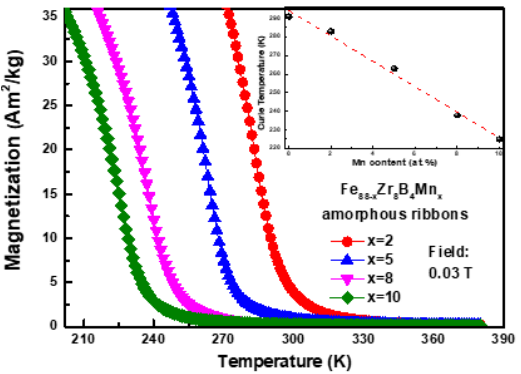
Figure 4. The temperature dependence of the magnetization (M-T) curves of the Fe 88 − x Zr 8 B 4 Mn x samples, inset the compositional dependence of T c in Fe 88-x Zr 8 B 4 TM x (TM=Co, Mn) metallic glasses. Figure 5 shows the hysteresis loops of the amorphous Fe 88 − x Zr 8 B 4 Mn x (x = 0, 2, 5, 8 and 10) samples measured at 200 K under 5 Tesla. The ribbons are all soft magnetic and exhibit negligible coercivity, indicating that the new series of FeZrB alloys is similar to the based alloys that are potential materials for practical application because they can easily be magnetized and demagnetized. The saturation magnetization ( M s ) of the Fe 88 − x Zr 8 B 4 Mn x glassy ribbons is about 109 Am 2 /kg for x = 0, 94.6 Am 2 /kg for x = 2, 80.3 Am 2 /kg for x = 5, 65.4 Am 2 /kg for x = 8 and 58.33 Am 2 /kg for x = 10. To facilitate observation, Figure 5 plots the variation curve of M s and Mn content inset in the lower right corner. The M s of the samples decreased dramatically as the Mn content increased, which